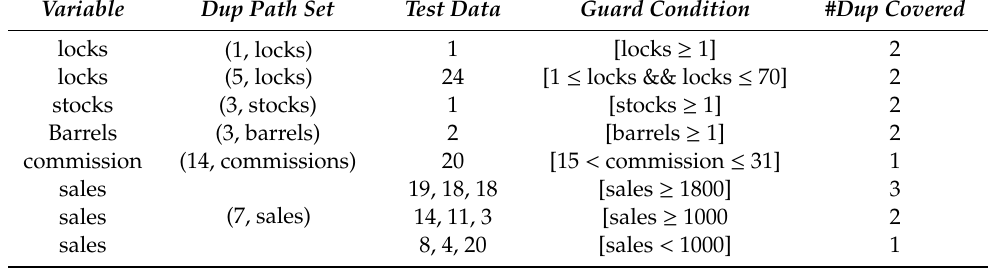
Table 2. The generated test data and associated information.